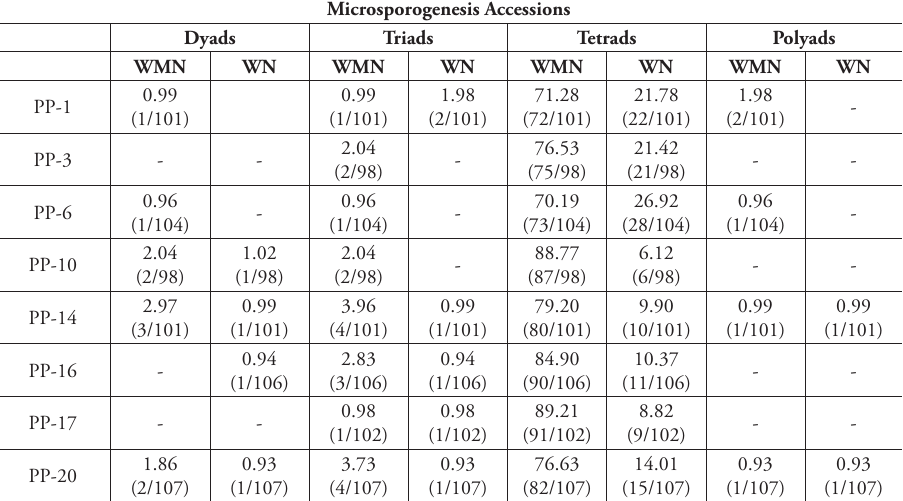
Table 4. Data on abnormal microsporogenesis in different cytotypes of Valeriana jatamansi marked with abnormal